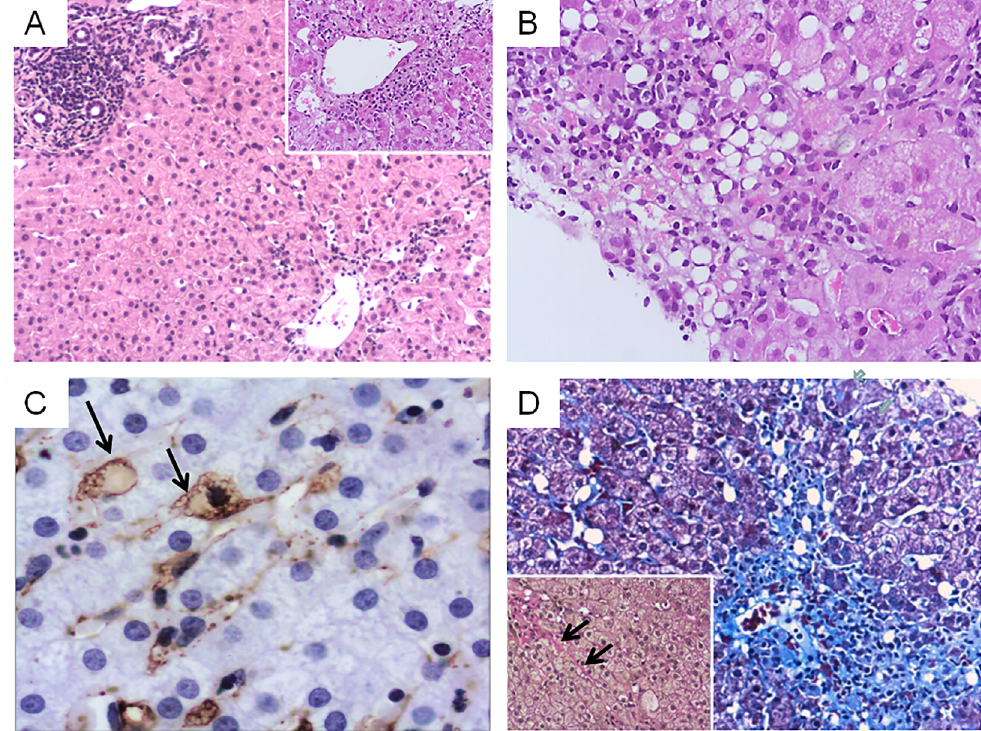
Figure 1. Combined liver injury related to consumption of multi-ingredient nutritional oral supplements containing Aloe Vera gel and vitamin A. A. Acute hepatitis pattern (HE, ×100) with confluent necrosis in zone 3 (inset, ×200) B. Lipogranulomatous reaction (HE, ×200) C. Hypertrophic HSC containing lipid droplets (arrows) highlighted by α-smooth muscle actin immunohistochemistry (3’3’ diaminobenzidine chromagen, ×400) D. Zone 3 necrosis and collapse with immature fibrosis (Masson trichrome, ×100). Inset: van Gieson stain highlights focal perisinusoidal fibrosis, ×200 (arrows) Table 1. Score results of the present case according to the updated RUCAM for hepatocellular injury* Items for hepatocellular injury score result Score